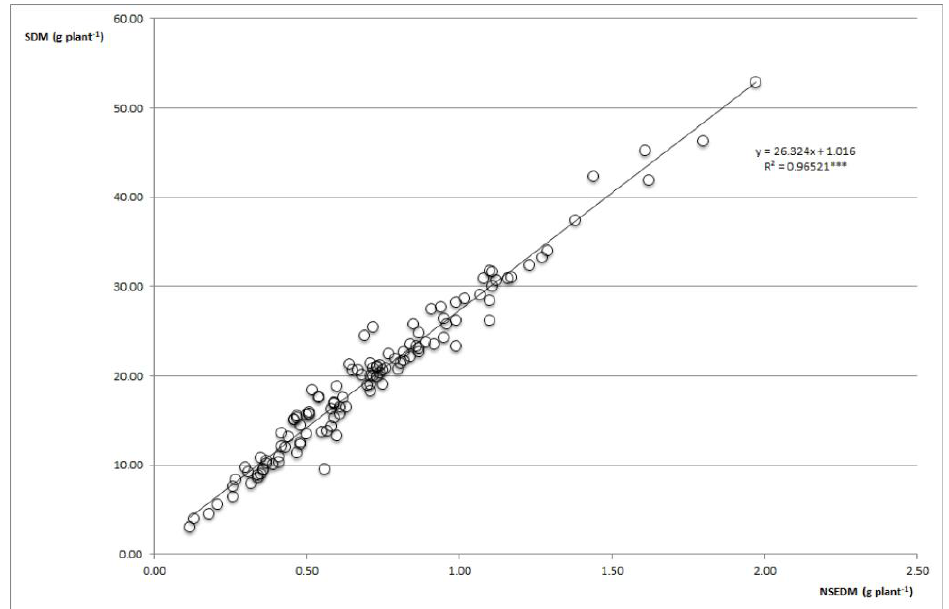
Figure 4. NSEDM vs. SDM ratio under water stress in the field. *** p < 0.0001.